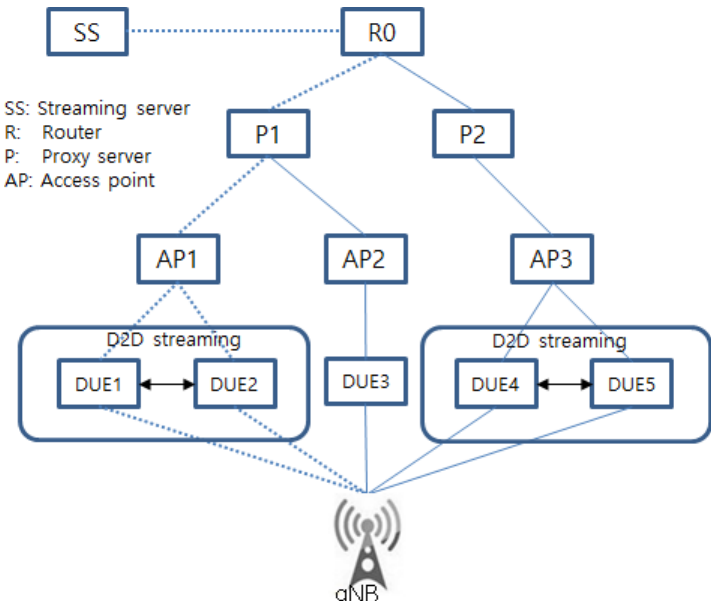
Figure 4. Network model for simulation.